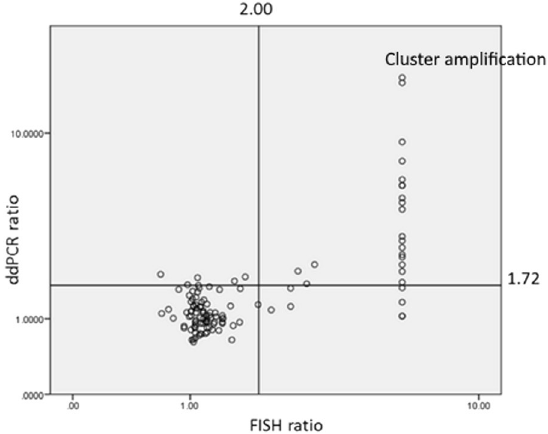
Figure 2. Correlation of HER2:CEP17 ratio between ddPCR and FISH in validation